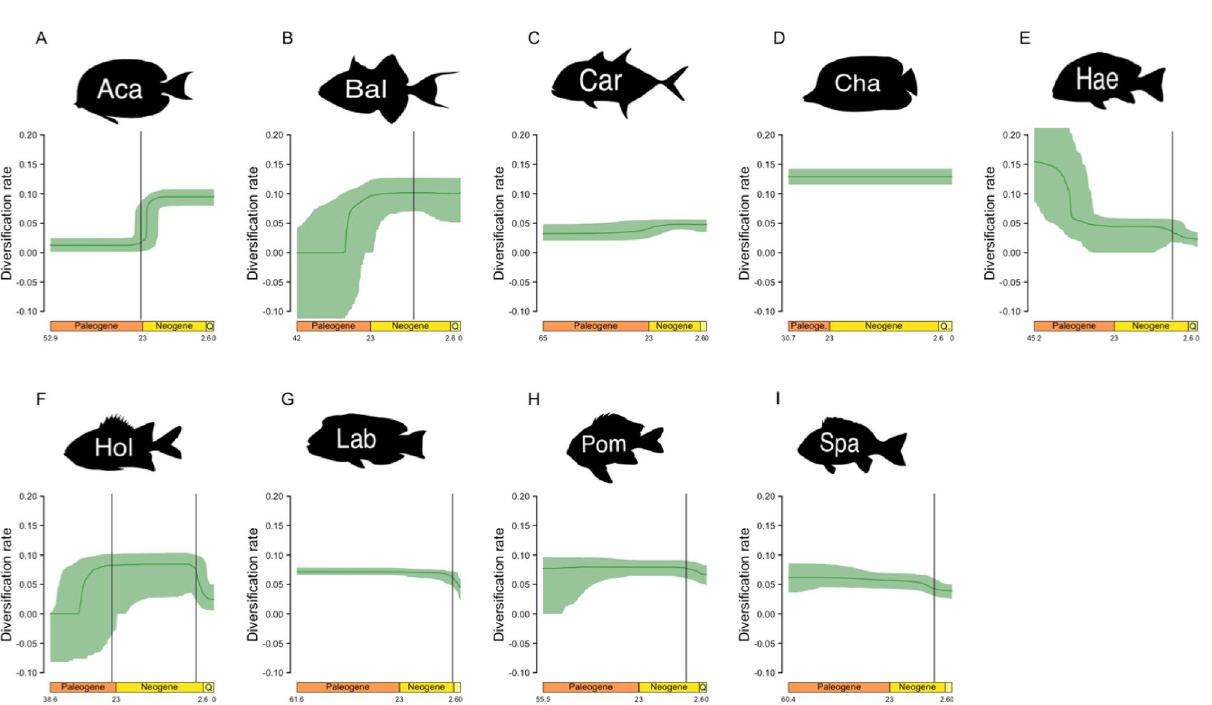
Figure 2. Diversification rates through time estimated under the birth–death-shift model. The dark green line represents the median diversification rate of the trees from the posterior distribution calculated every 100,000 years. The light green area represents the first and the ninth decile of the diversification rate distribution estimated every 100,000 years. We present the estimated diversification rates based on the posterior distribution of trees to represent the errors linked to phylogenetic and dating uncertainties. Thus, clades that are expected to display a constant diversification rate based on their consensus tree, can display temporal variation in diversification rates here. The dark grey line represents the date of the diversification rate shift estimated on consensus trees. Aca Acanthuridae, Bal Balistoidea, Car Carangoidea, Cha Chaetodontidae, Hae